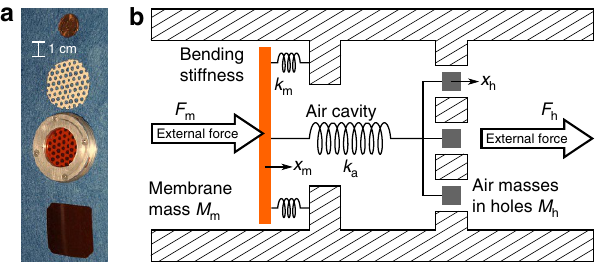
Figure 2 | Photograph and mechanical schematic of the effective material element. A photograph of the assembled element is shown second from the bottom of ( a ) along with membrane and perforated paper samples and a US 1-cent coin for scale. The membrane is 0.125mm thick and the paper is 0.45mm thick with 3.1mm-diameter circular holes. The membrane and the paper are separated by a 5.9mm-thick air cavity using an aluminum holder. The mechanical schematic shown in b describes the behaviour of the effective material element in the long-wavelength limit as a membrane with a mass M m and bending stiffness k m , an air cavity with stiffness k a and air masses in the holes of a plate with mass M h